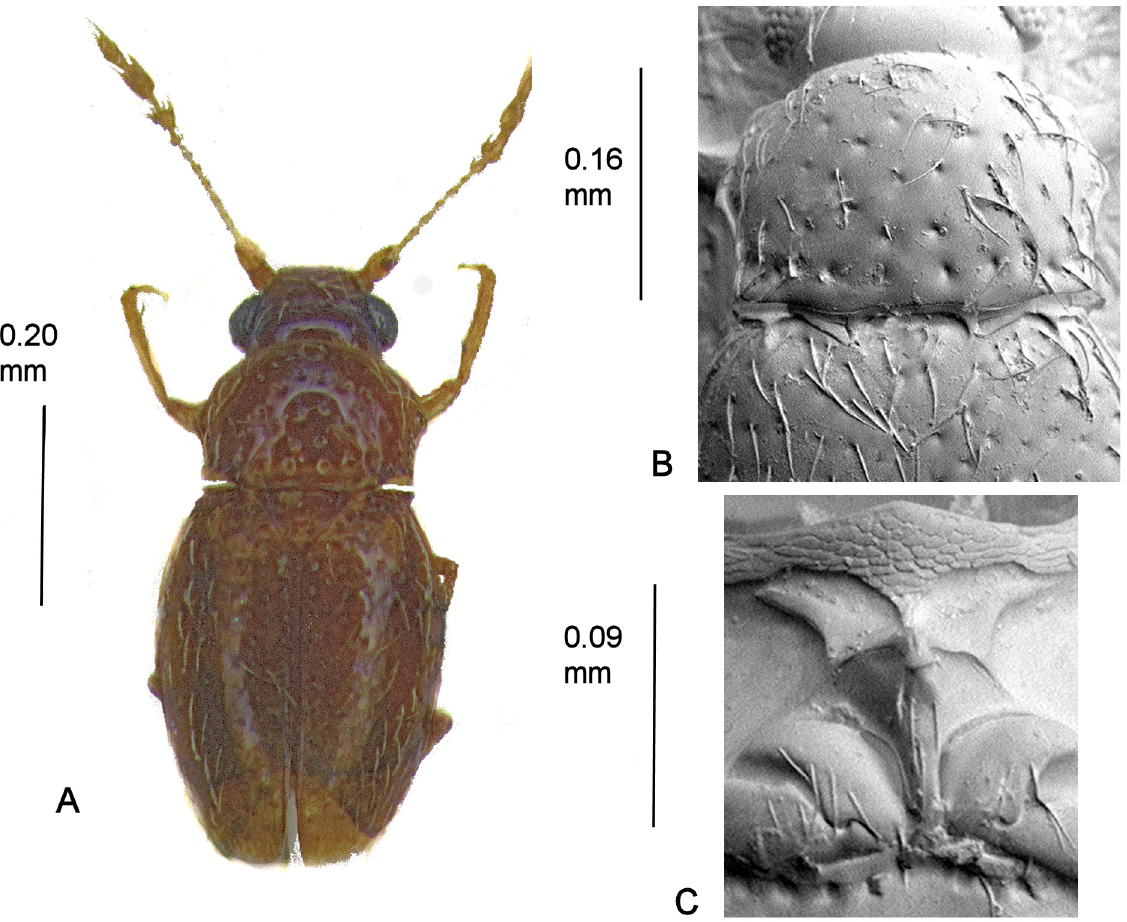
Fig. 108 . Cissidium brachypterum sp. nov. A . Habitus. B . Pronotum, × 485. C . Mesoventrite showing median process of collar, mid-keel and keel,